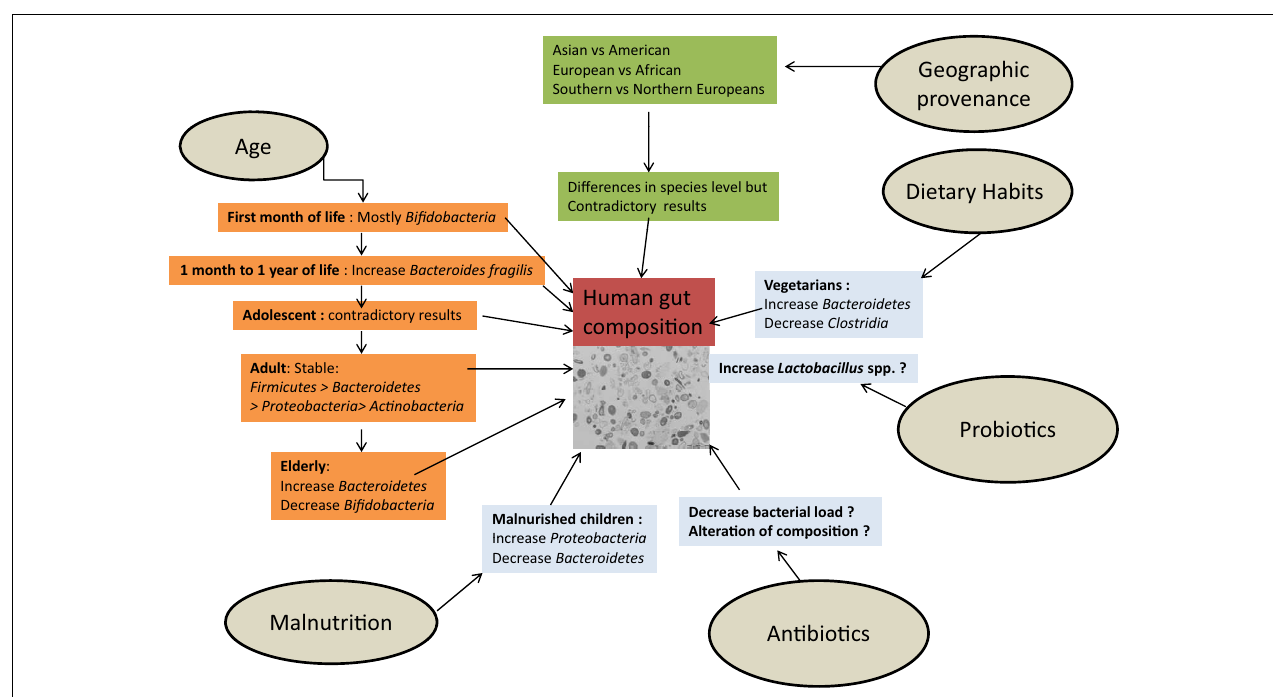
FIGURE 6 |The influence of external factors determining the composition of the human gut